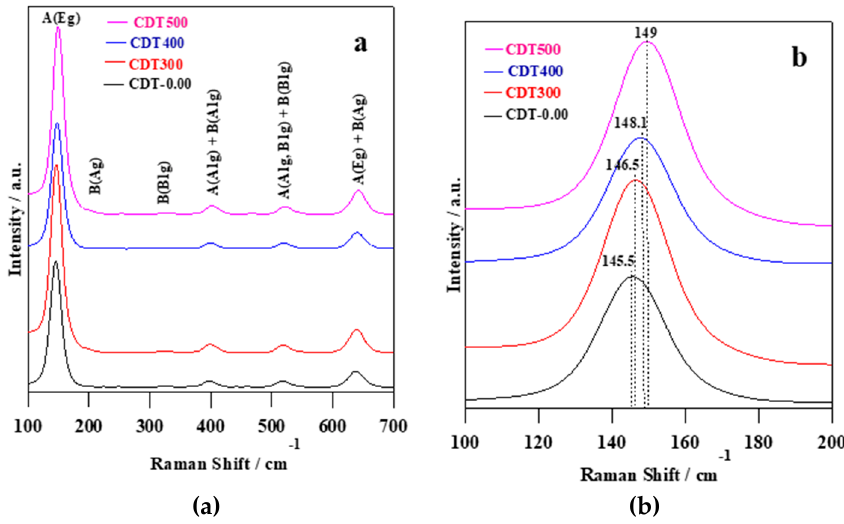
Figure 2. ( a ) Raman spectra of CDT-0.00, CDT-300, CDT-400, and CDT-500 samples; and ( b ) enlargement of the main peak around 145 cm − 1 . Table 2. Raman vibration bands and their assignments in CDT-0.00, CDT-300, CDT-400, and CDT-500 samples at 532 nm excitation